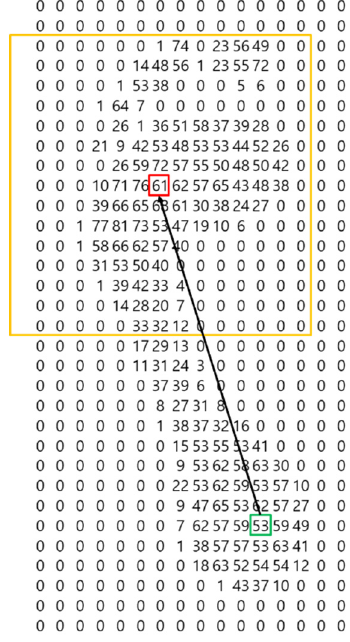
Figure 6. Angular measurement based on centers of gravity.